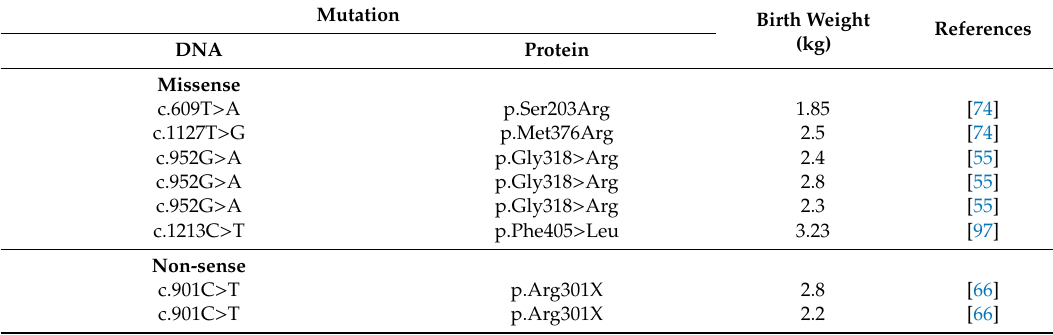
Table 4. Summary of di ff erent types of GLUT2 mutations associated with Fanconi–Bickel Syndrome and the Patient Birth